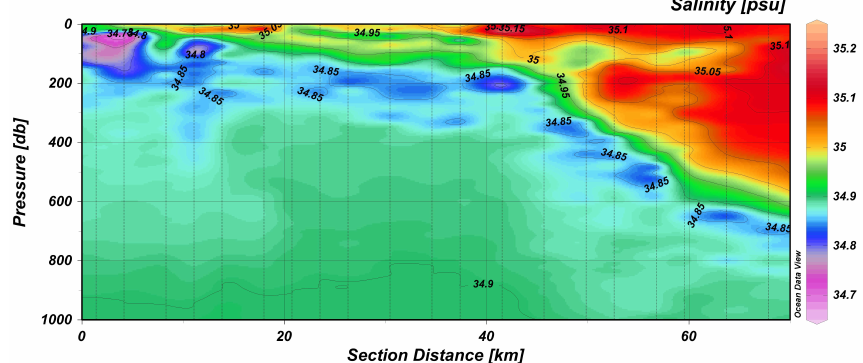
Fig. 11. Low-salinity intrusion of the Arctic waters towards the Atlantic domain.